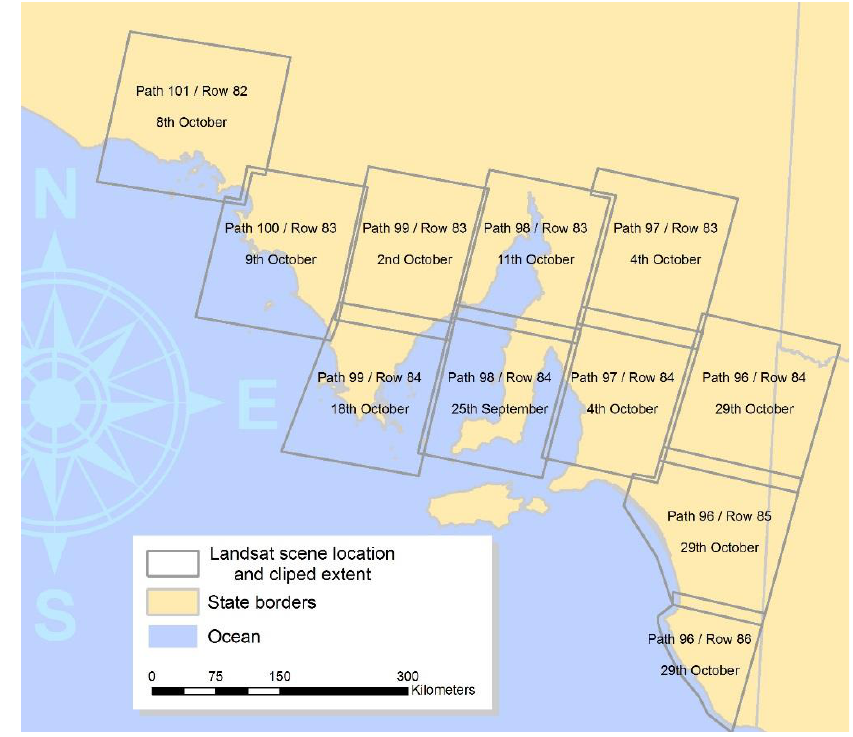
Figure A1. Mosaicked Landsat scene dates for the 2004 growing season.